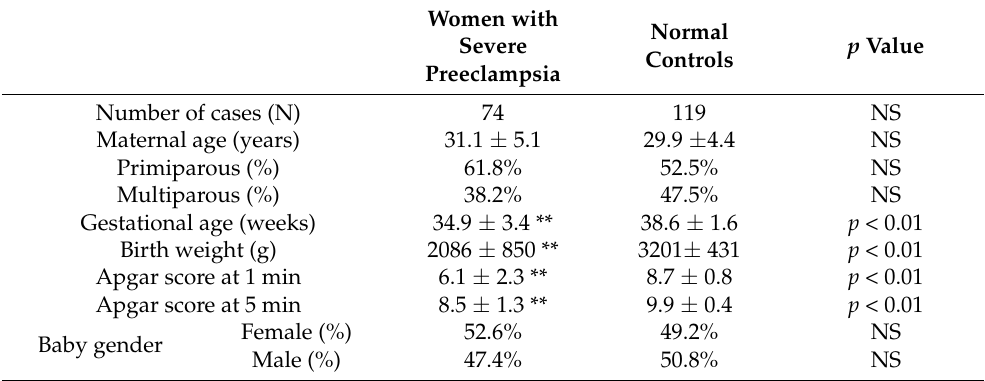
Table 1. Clinical characteristics and pregnancy outcomes of women with severe preeclampsia and normal